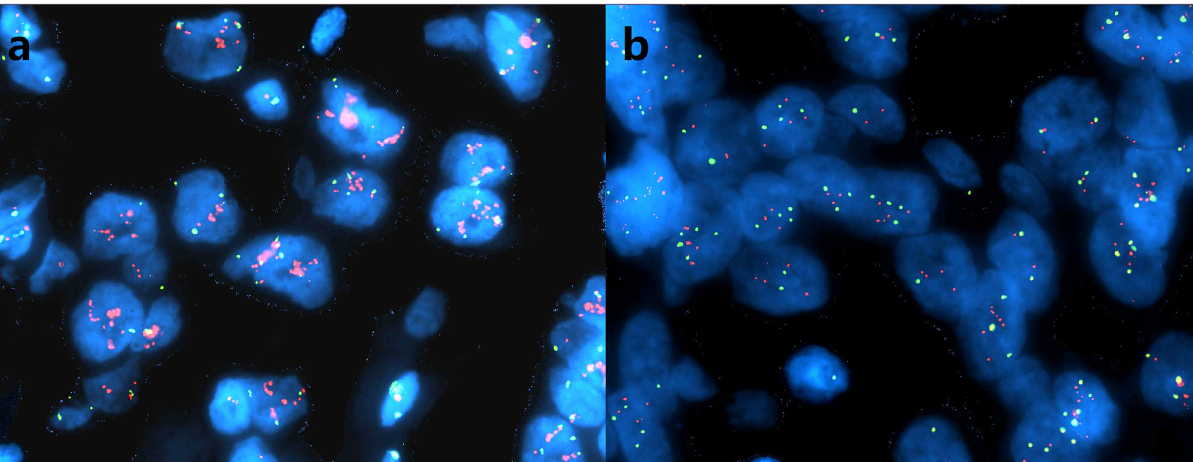
Fig 1. FISH analysis on EGFR gene amplification in MBC. Representative images of amplification of EGFR (a) and high aneusomy of EGFR (b). EGFR gene amplification was defined as a ratio of EGFR gene vs chromosome 7 centromere signals (cid:1) 2.0. EGFR FISH-amplified samples also included those with (cid:1) 40% of tumor cells demonstrating (cid:1) 4 copies of EGFR gene.